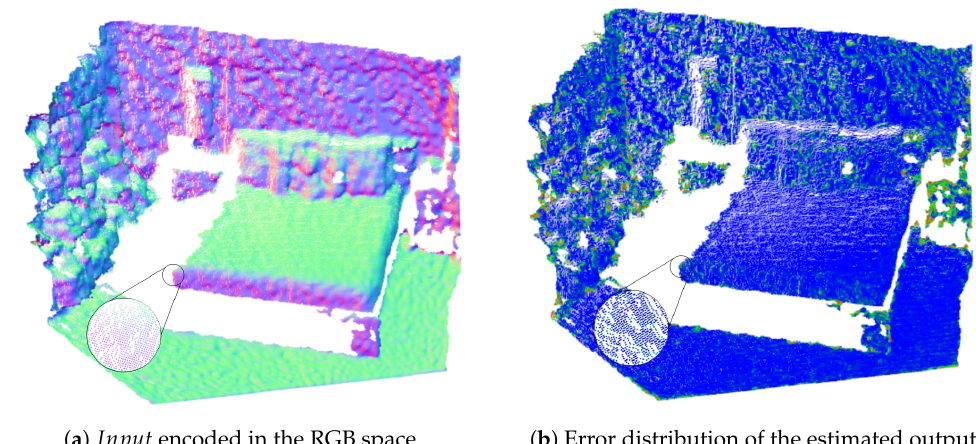
Figure 4. The absolute normal orientation error as represented by our technique as a heat map.